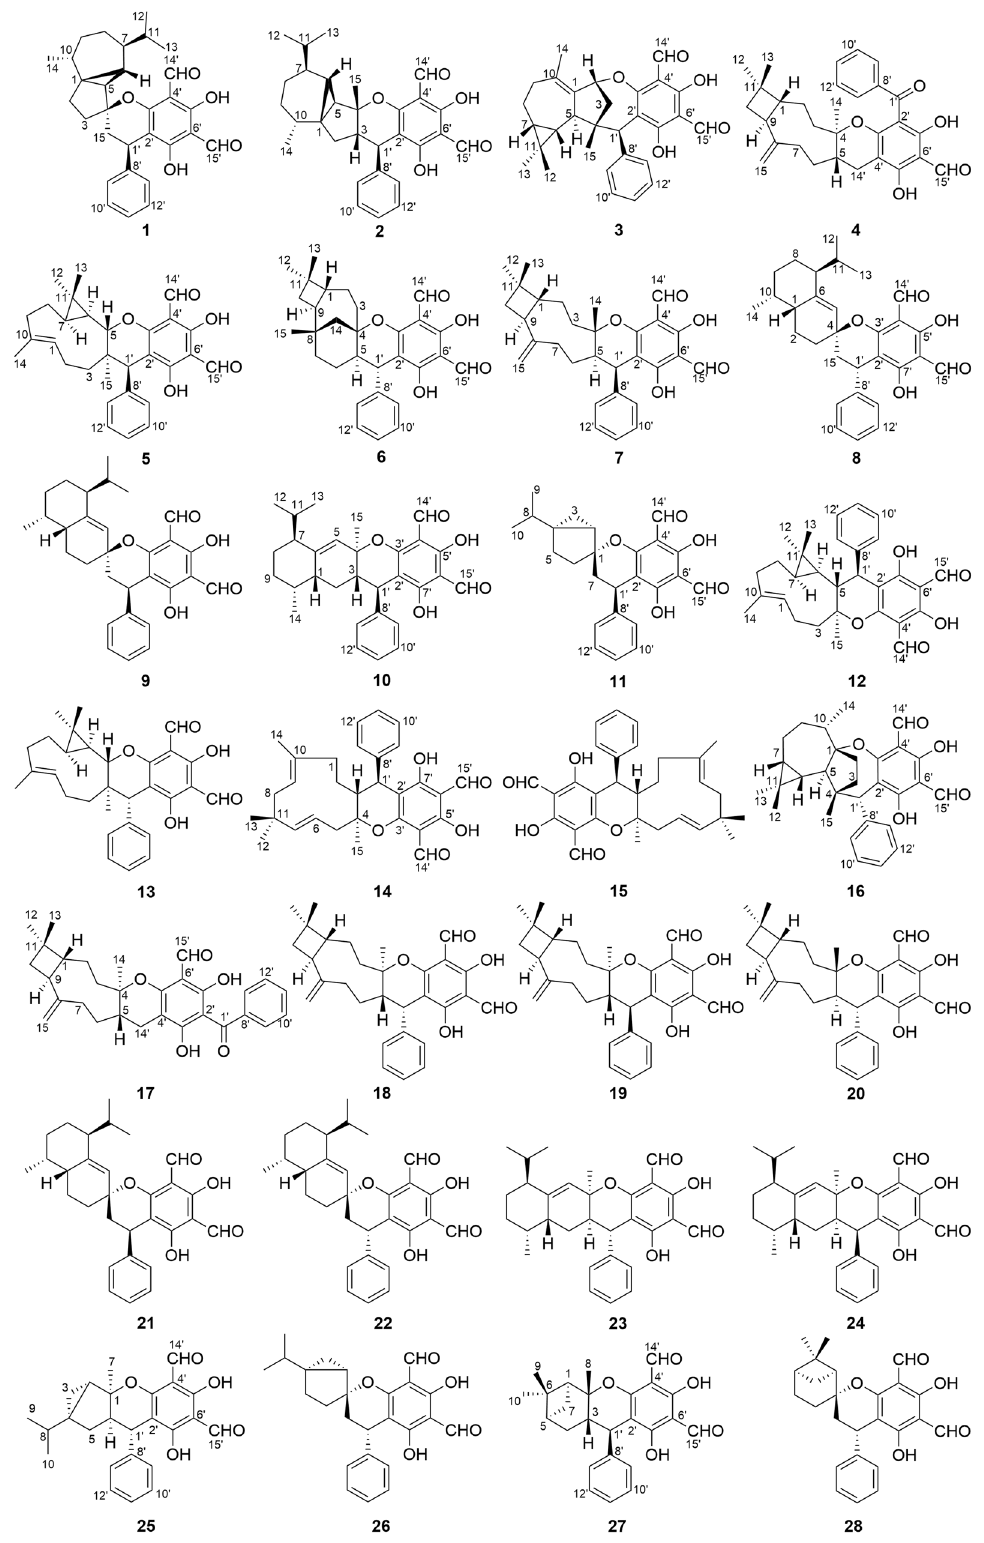
Figure 1. Structures of compounds 1 – 28